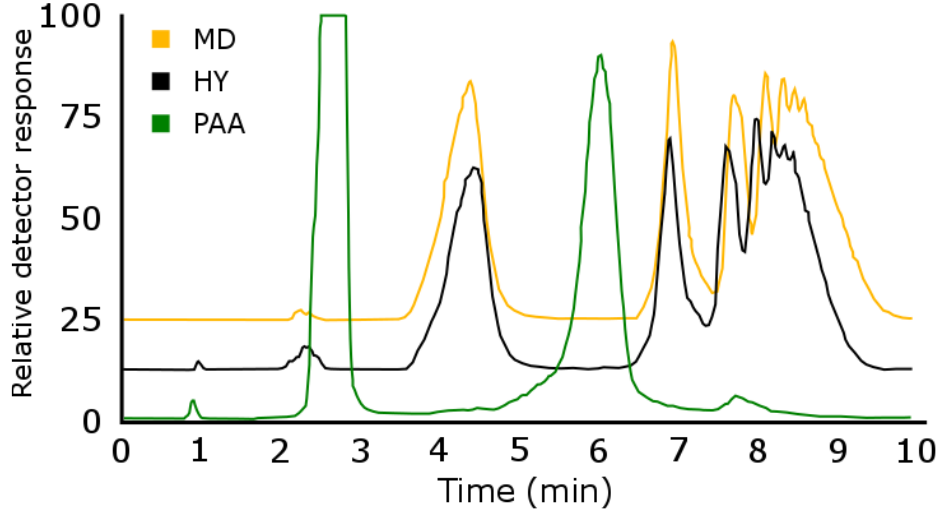
Figure 6. HILIC separation of PAA, HY, and MD samples (2 µL injection, 8.5 mg/mL dissolved in 100% H 2 O, 0.1% FA), obtained on a HILIC Kinetex bare-silica column (150 × 4.6 i.d., 2.6 µm particles). Mobile phase A: 100% H 2 O (0.1% FA); mobile phase B: 100% ACN (0.1% FA); flow rate: 1 mL/min; gradient: 96 – 10% B, (1 to 8 min). ELSD detection. Chromatograms are shifted in the y-direction for clarity.